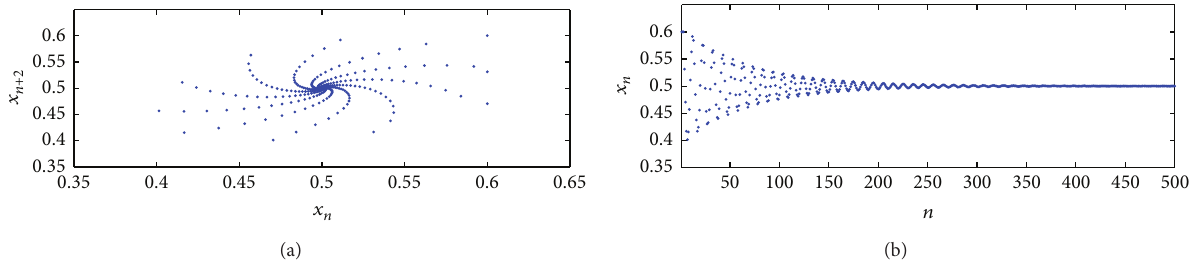
Figure 1: The positive equilibrium is asymptotically stable, where 𝑎 1 = 1.6 , 𝑎 2 = 0.8 , 𝑚 = 2 , and 𝑟 = 0.49 < 𝑟 1 = 0.515 .